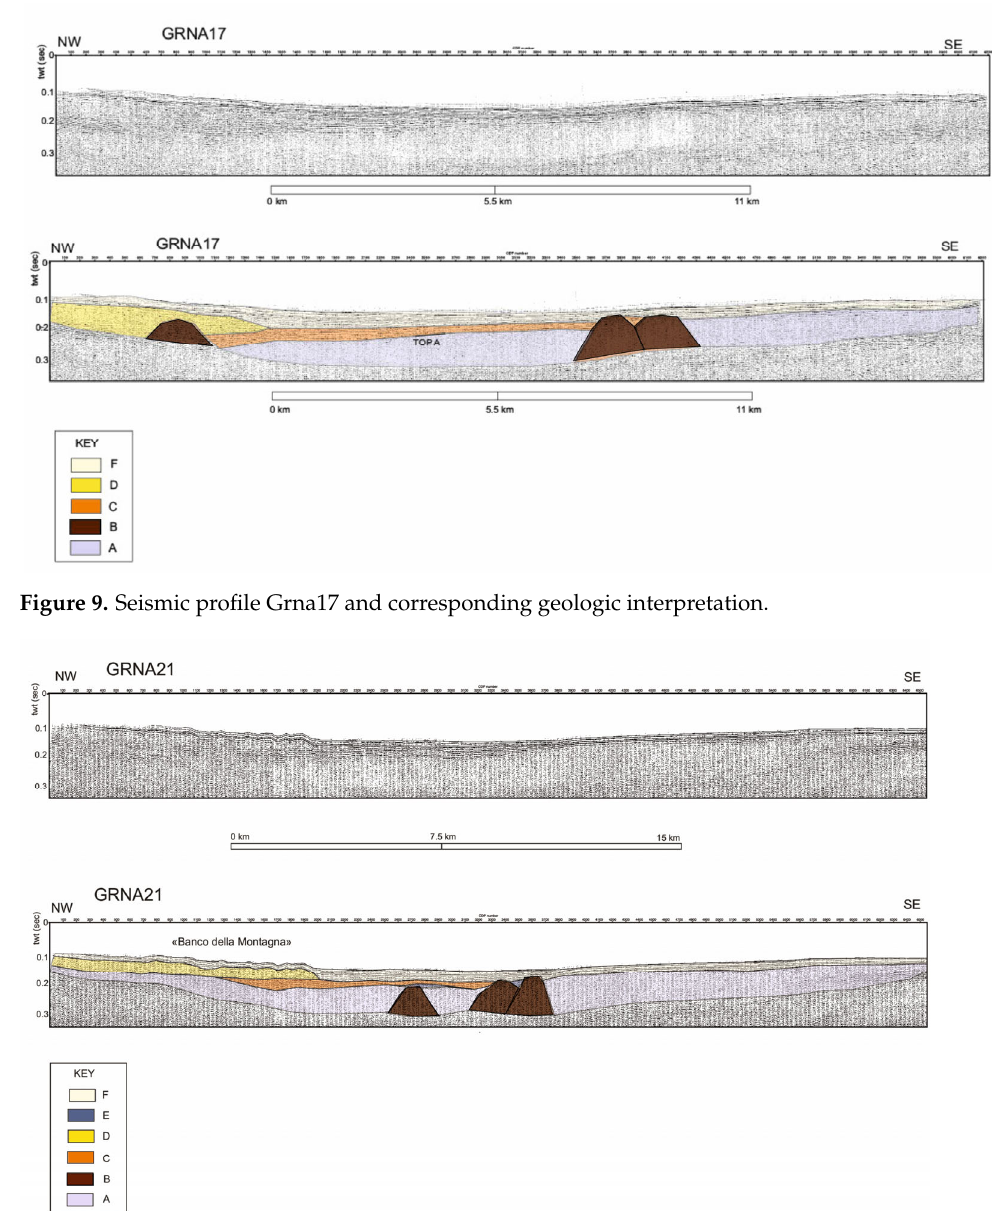
Figure 10. Seismic profile Grna21 and corresponding geologic interpretation.